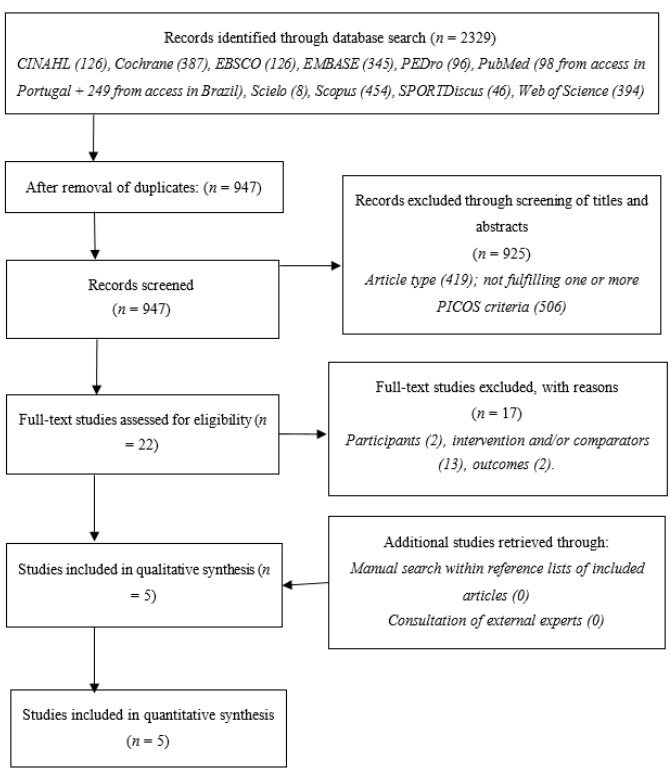
Figure 1. Flowchart describing the study selection process.